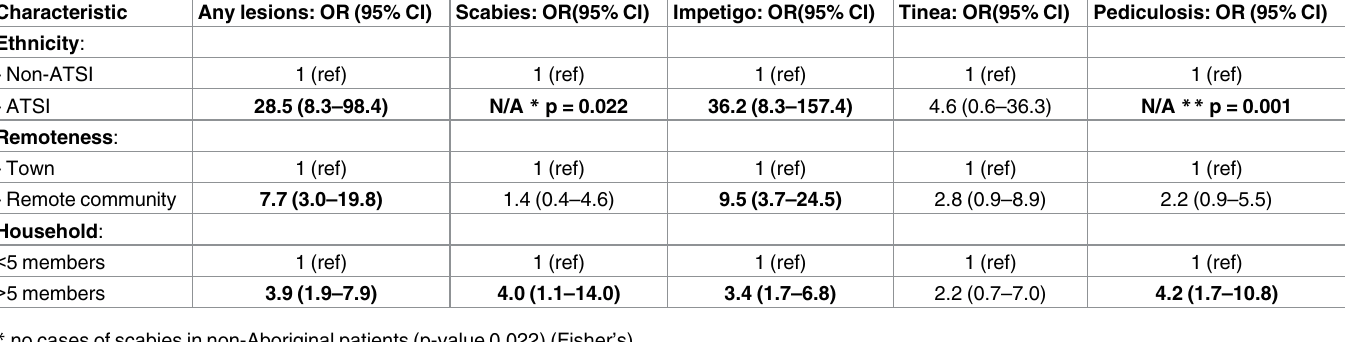
Table 4. Risk factors for skin infection (prospective only–univariate logistic analysis).